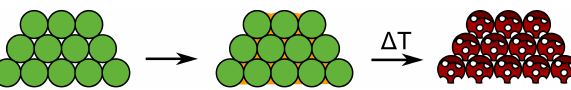
Figure 1. Scheme of the inverse opal synthesis by casting a PMMA opal: the PMMA spheres are deposited onto a glass slide at 60 ◦ C, and then the opal pores are filled with an indium nitrate solution. This composite is dried, the indium nitrate is thermally converted to indium oxide and the PMMA template is removed by